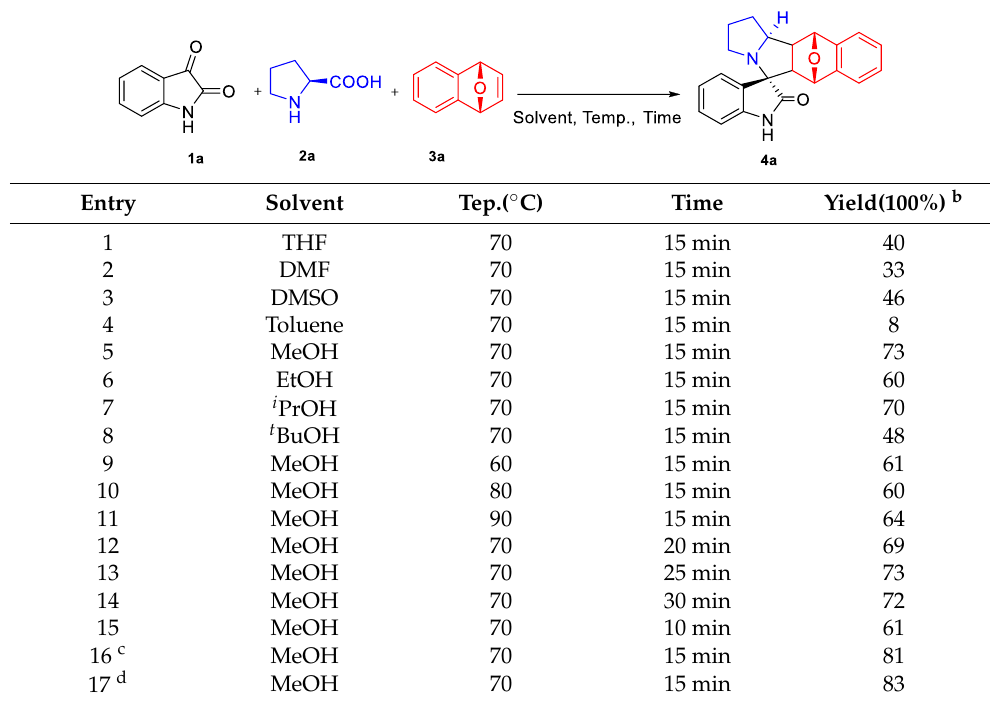
Table 1. Optimization of reaction conditions a .